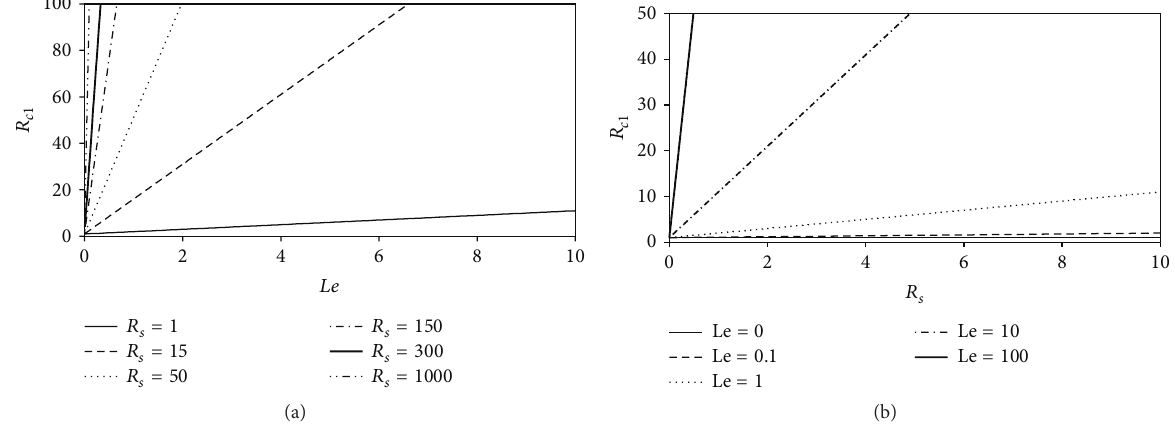
Figure 2: The critical Rayleigh number 𝑅 𝑐1 as function of (a) Le and (b) 𝑅 𝑠 .